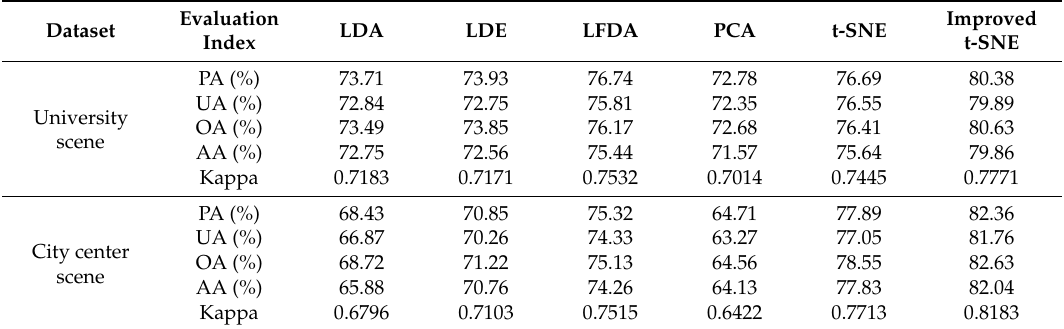
Table 7. Comparison of results assessment: both improved t-SNE method and other DR methods for spectral features